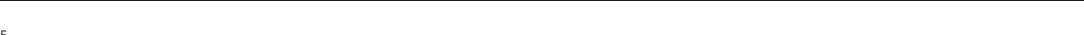
FIGURE5 Transcriptome profiles of inhibitory effects on neural activity induced by Bmal1 knockdown in the LSG. (A) Heatmap showing 7,820 genes with altered expression induced by Bmal1 knockdown. (B) Volcano plot showing upregulated genes, downregulated genes, and not the differentially-expressed genes in the Bmal1 knockdown group compared with the control group. (C) KEGG classifications of differentially expressed genes induced by Bmal1 knockdown. (D) KEGG pathway enrichment analysis of DEGs induced by Bmal1. (E) Part of GO biological process annotations of differentially expressed genes associated with neural activity induced by Bmal1 knockdown. Differentially expressed genes were identified as methods were mentioned. n = 3 for each group. LSG, left stellate ganglion; DEGs, differentially expressed genes; KEGG, Kyoto Encyclopedia of Genes and Genomes; GO, Gene Ontology.